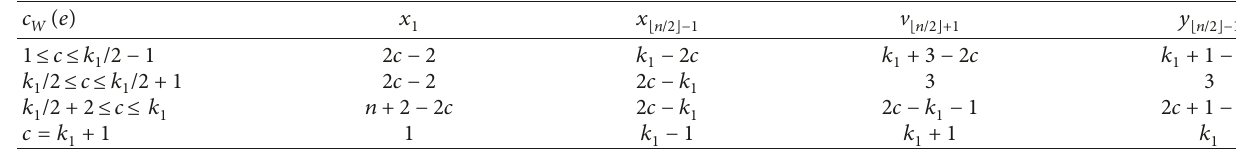
u c is odd. c c , when